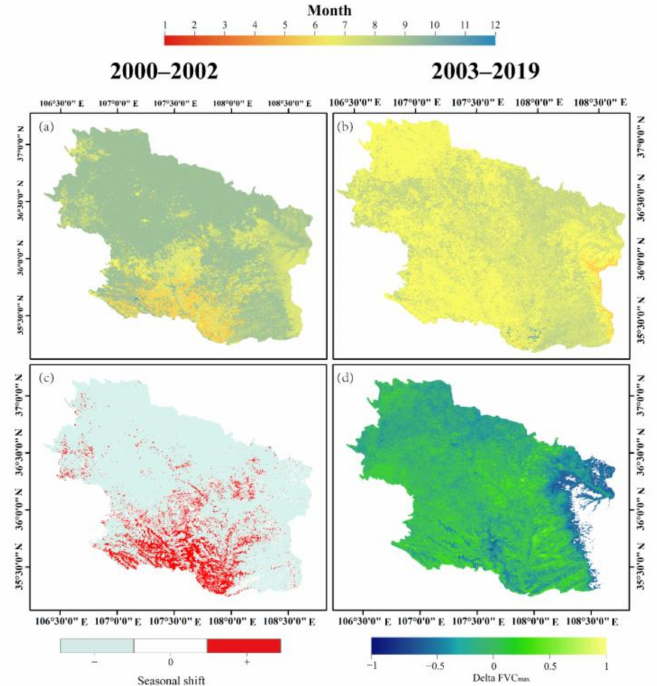
Figure 9. ( a ) Month with maximum vegetation activity derived from peak FVC from 2000–2002 and ( b ) 2003–2019. ( c ) Estimating seasonal phase shift (‘ − ’ dedicates an earlier while ‘+’ means a later occurrence of FVC max , and ( d ) seasonal amplitude change of FVC max